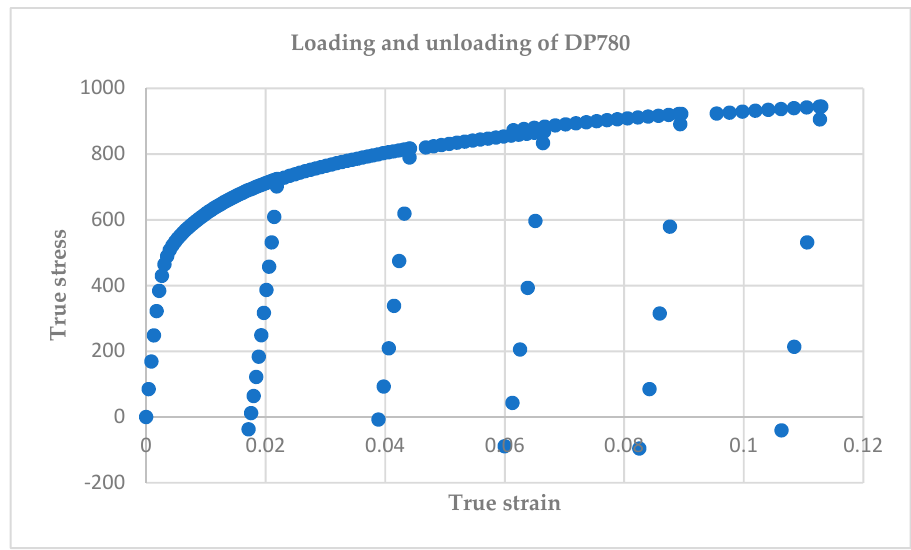
Figure 1. Stress-strain curve in tension compression test.